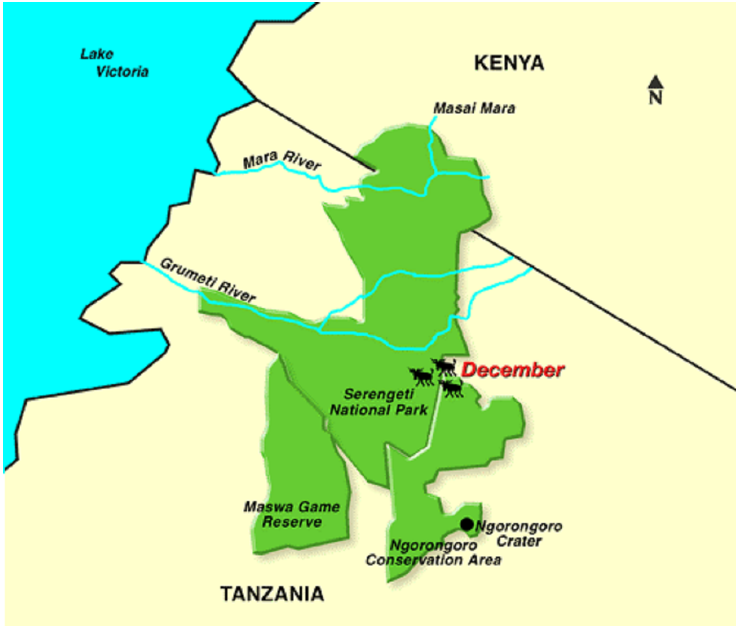
Figure 1. A map and a bird’s eye view on the target sightseeing spots analyzed in this study— Ngorongoro and Serengeti